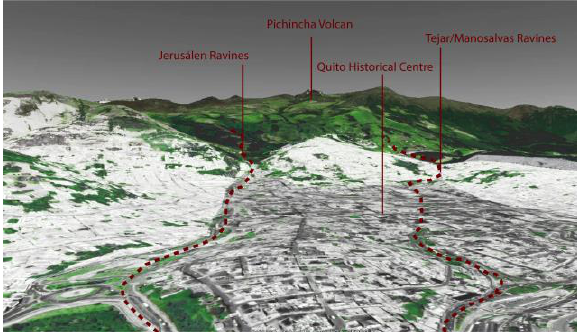
Figure 4. Quito’s ravine in relation with the contemporary urban fabric of the historical city centre. Credits: Paola Bracchi.